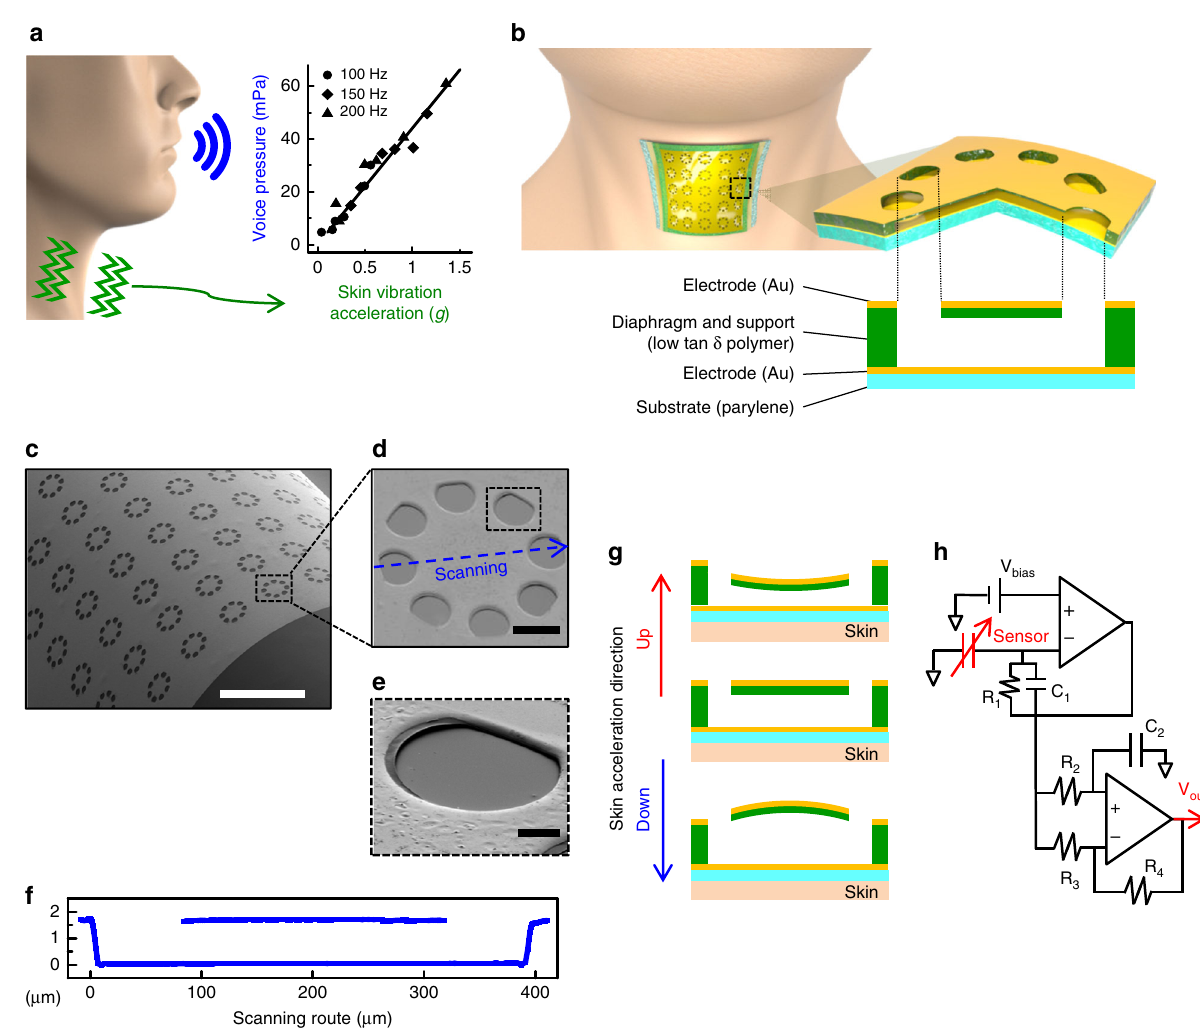
Fig. 1 Schematic design of vibration-responsive electronic skin. a Measurement data of neck skin acceleration and voice pressure at three fundamental voice frequencies of 100, 150, and 200 Hz. b Illustration of our electronic skin attached on neck and the diaphragm structure. Human bust images in ( a , b ) were created based on a base-mesh, adapted with permission from https://www.deviantart.com/chrrambow/art/Bust-Basemesh-128960722. Copyright 2009 by Christian Rambow. c SEM image of diaphragm array on a curved surface with bending radius of 2.5 mm. d SEM images of hole patterns on the suspended diaphragm. e Magni fi ed SEM image of the hole pattern shown in the dashed line rectangle of the SEM image ( d ). f Height pro fi le of cross- sectional view for a suspended diaphragm structure. Scanning route is shown as a blue dotted arrow in the SEM image ( d ). g Schematic illustration during the movement of a diaphragm when the skin vibrates. h Interface conditioning circuit diagram connected to the sensor. Scale bars: 1 mm ( c ); 100 μ m ( d ); 20 μ m ( e